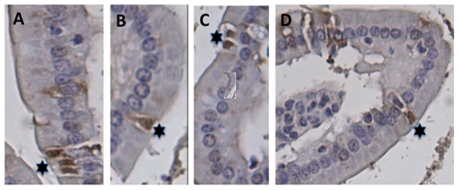
Localization of EC cells in the small intestine of mice.(A–D) Sections of paraffin-embedded small intestine tissue from uninfected BALB/c mice were processed for immunohistochemistry with rabbit anti-chromogranin A and peroxidase-labelled goat-anti rabbit. The EC cells were identified in all segments of the small intestine. (A) Ileum, (B–D) duodenum. Stars indicate chromogranin A containing-EC cells.